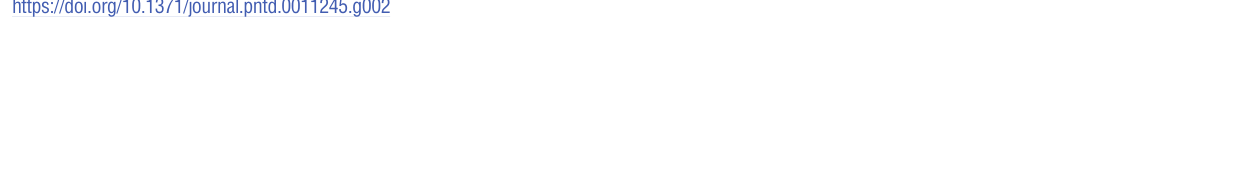
PLOS NeglectedTropical Diseases | https://doi.org/10.1371/journal.pntd.0011245 April 24,